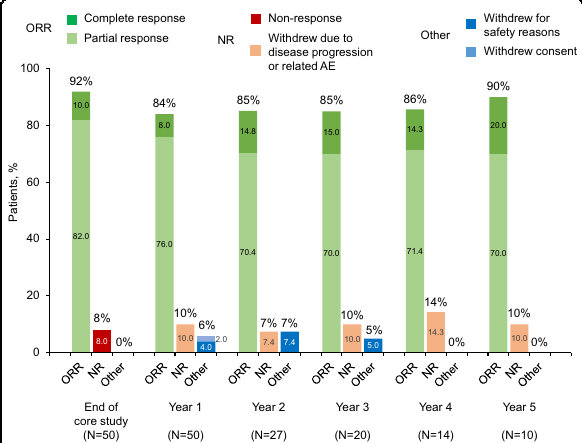
Fig. 1 Therapeutic response evaluation according to revised clinico-hematological ELN criteria (ITT population). Note that as this is an ongoing study, patients currently in the study have received varying durations of therapy. At the time of these analyses, 31 patients were still in the study. Percentages are calculated from the number of patients with data available at each timepoint (sum of the patients attending the stated visit and patients who withdrew from the study between visits due to disease progression or related AE, withdrew for safety reasons or withdrew consent). ORR overall response rate (total of partial and complete response), NR non-responder, AE adverse